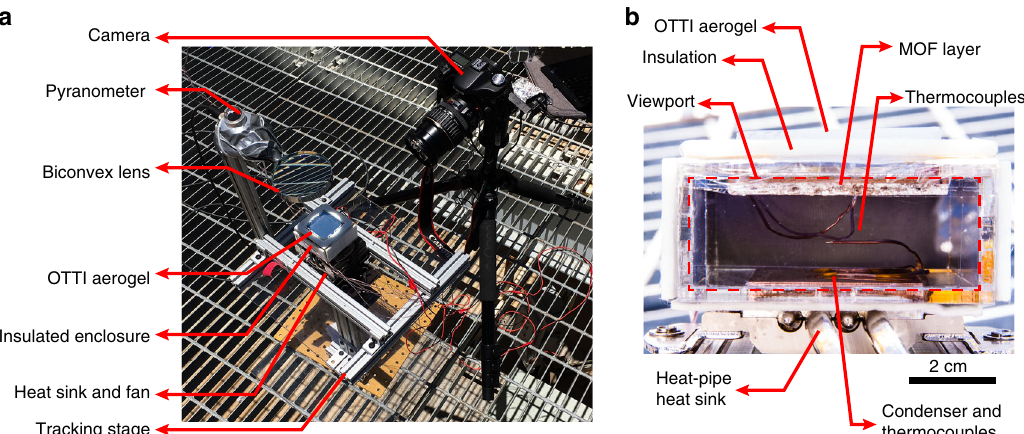
Fig. 2 Water harvesting device test apparatus. a Photo of the device test apparatus during the solar-assisted water production with 1.8× optical concentration. Test location: Tempe, AZ, USA. b Photo of the water harvesting device showing the MOF layer (5 cm by 5 cm base, porosity of 0.67 or packing density of 464 kg m − 3 with 2.57 mm thickness), condenser (4 cm by 4 cm), and thermocouples through the view port. The OTTI aerogel, heat pipe heat sink and insulation are also shown